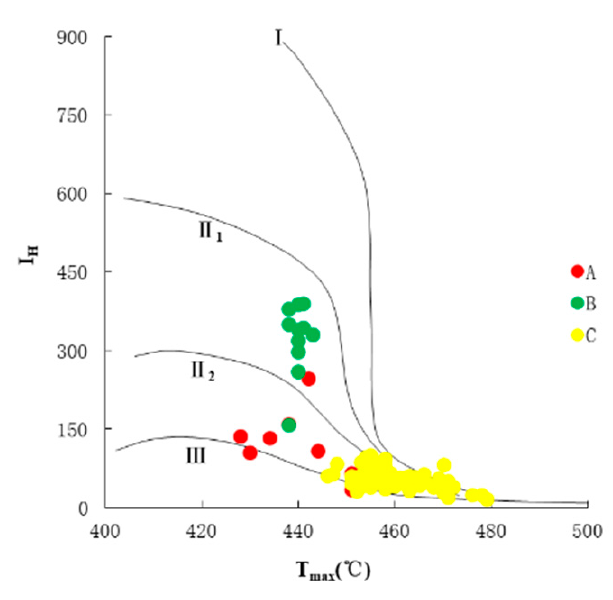
Figure 6. Cross plot of hydrogen index (HI) and T max . Table 2. Results from geochemical Rock-Eval/TOC analysis with calculated parameters from Yueguifeng Formation.